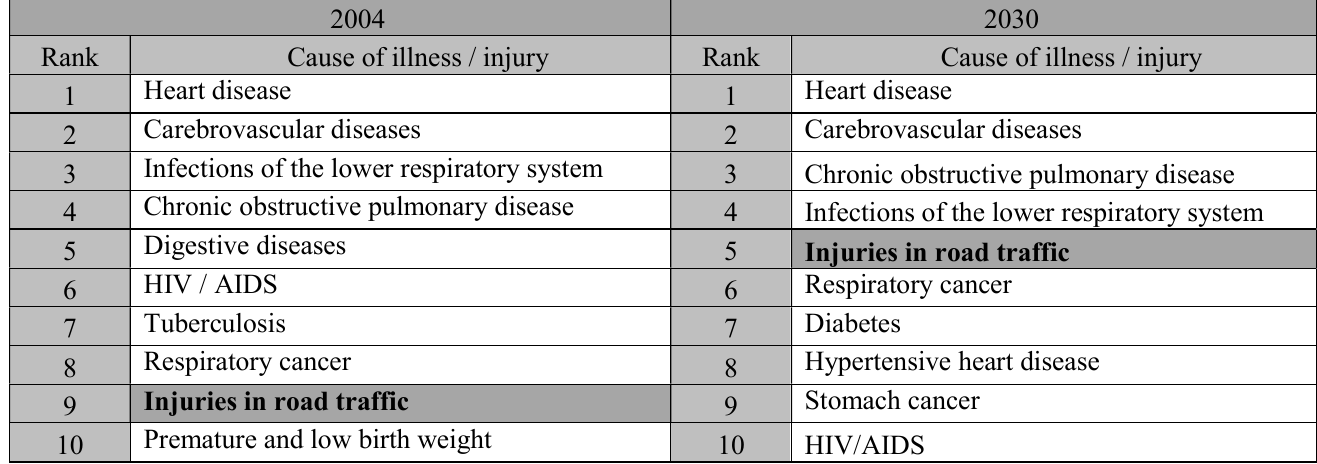
Table 1. Growth trend of traffic impact on the number of injured and traffic-related